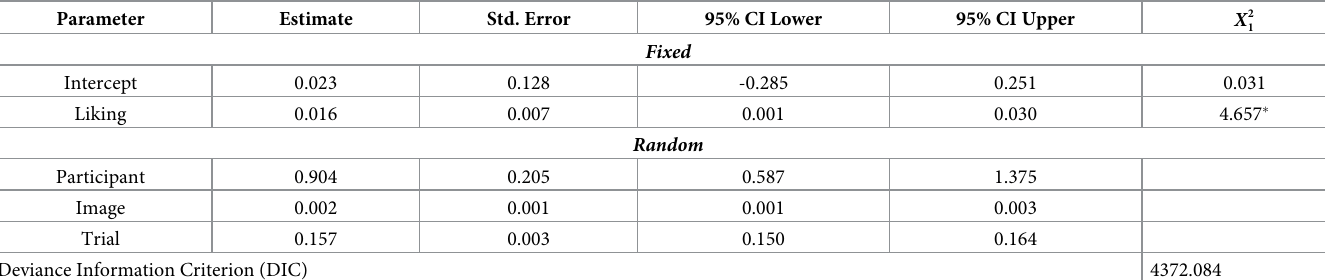
Table 2. Fixed effects estimates (top) and random effect variance estimates (bottom) for the model with best fit (Model 2a; Table